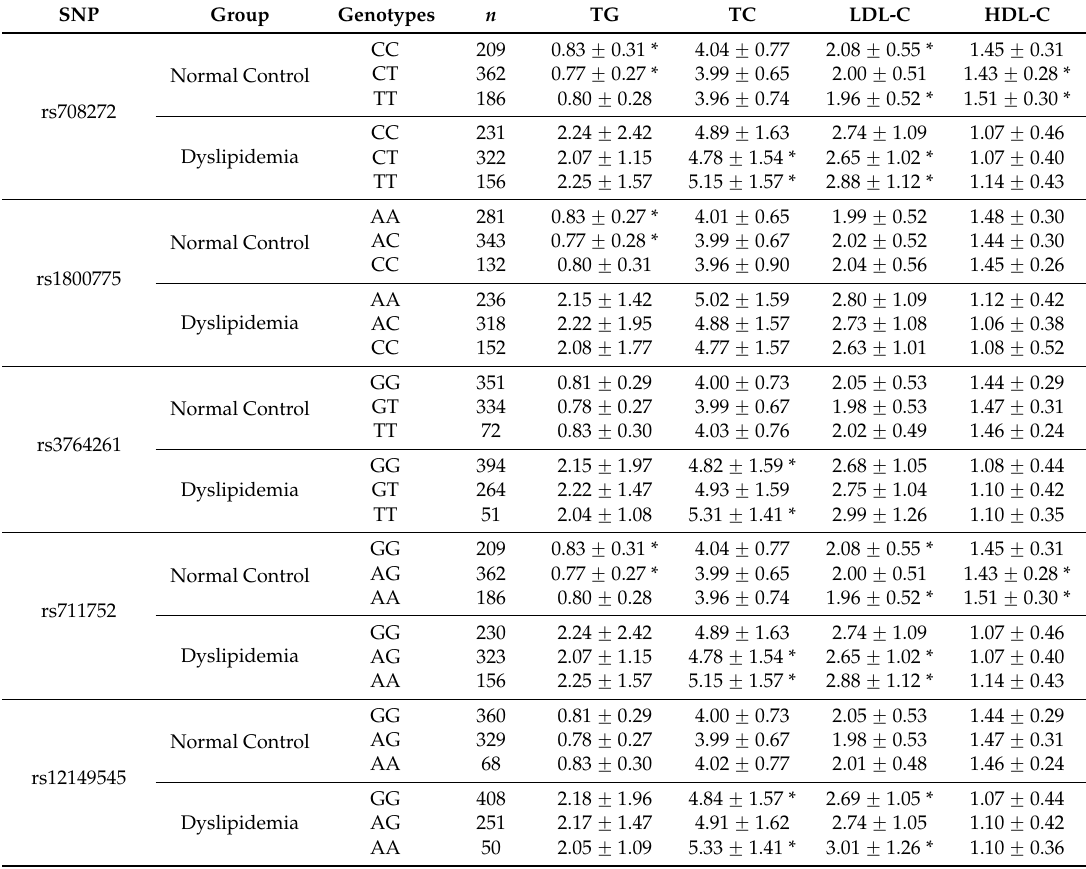
Table 3. Association of the Polymorphisms in CETP gene with TG, TC, LDL-C and HDL-C in two